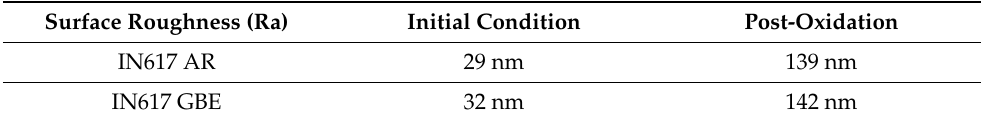
Table 3. Surface roughness of air-oxidised IN 617 AR and IN 617 GBE sample. Surface Roughness